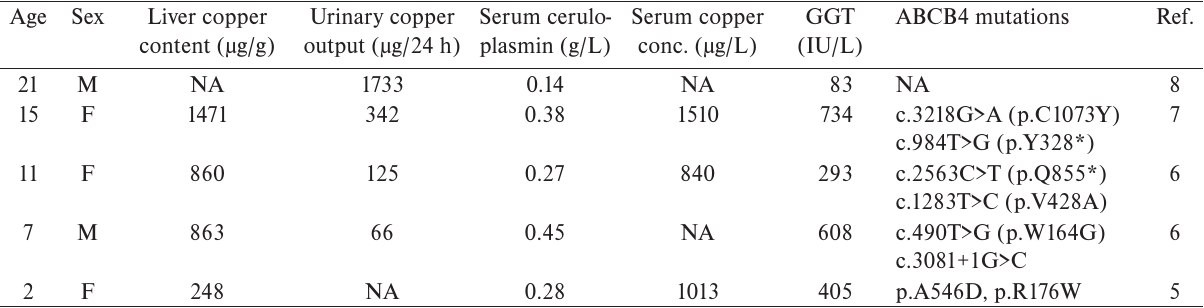
Table 1. Published patients with PFIC3 mimicking Wilson